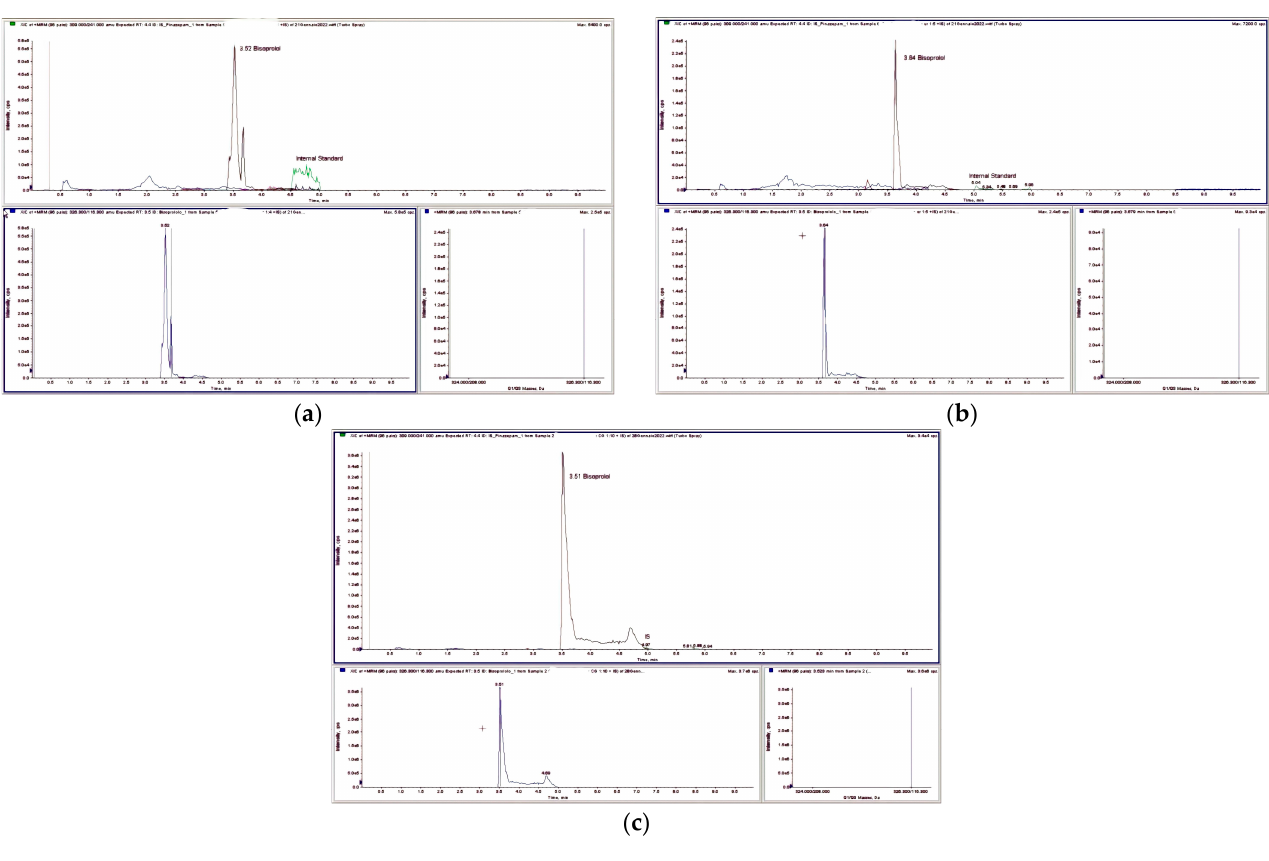
Figure 1. Figure 1 shows the LC-MS/MS chromatograms for Bisoprolol and internal standard in postmortem biological matrices ( a ) blood, ( b ) urine, and ( c ) gastric content. postmortem biological matrices ( a ) blood, ( b ) urine, and ( c ) gastric